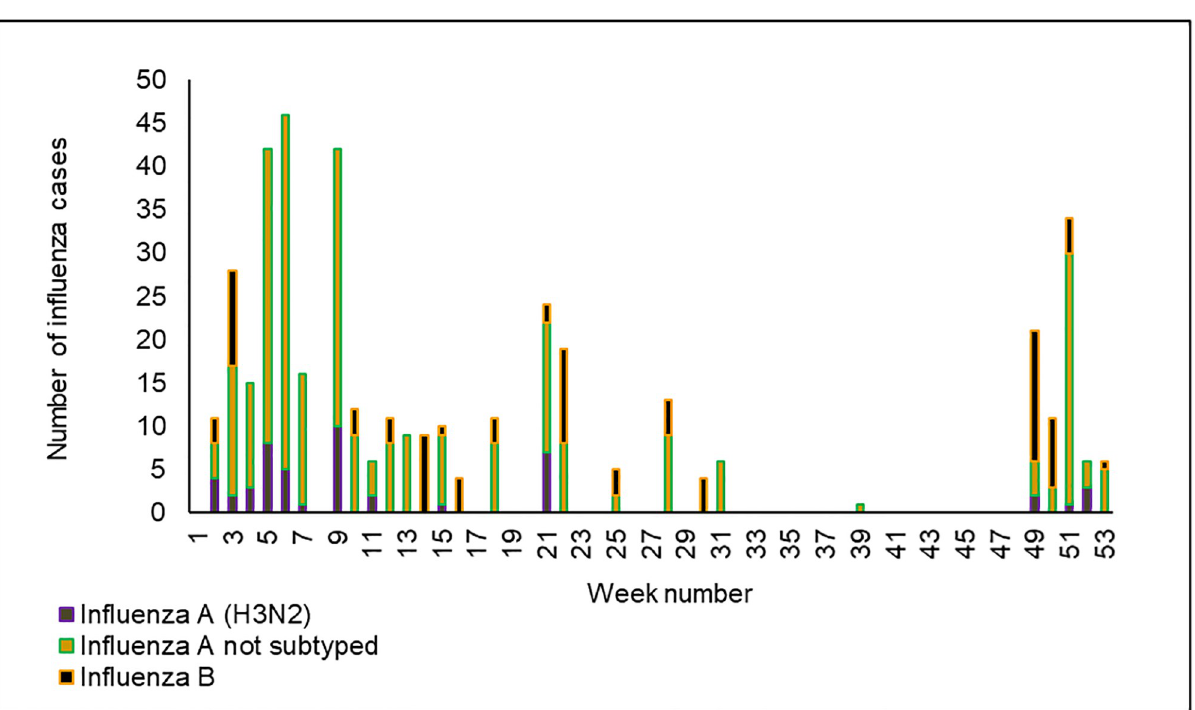
Fig 2. Weekly distribution of influenza cases in Tanzania from January to December 2019 (N = 373).